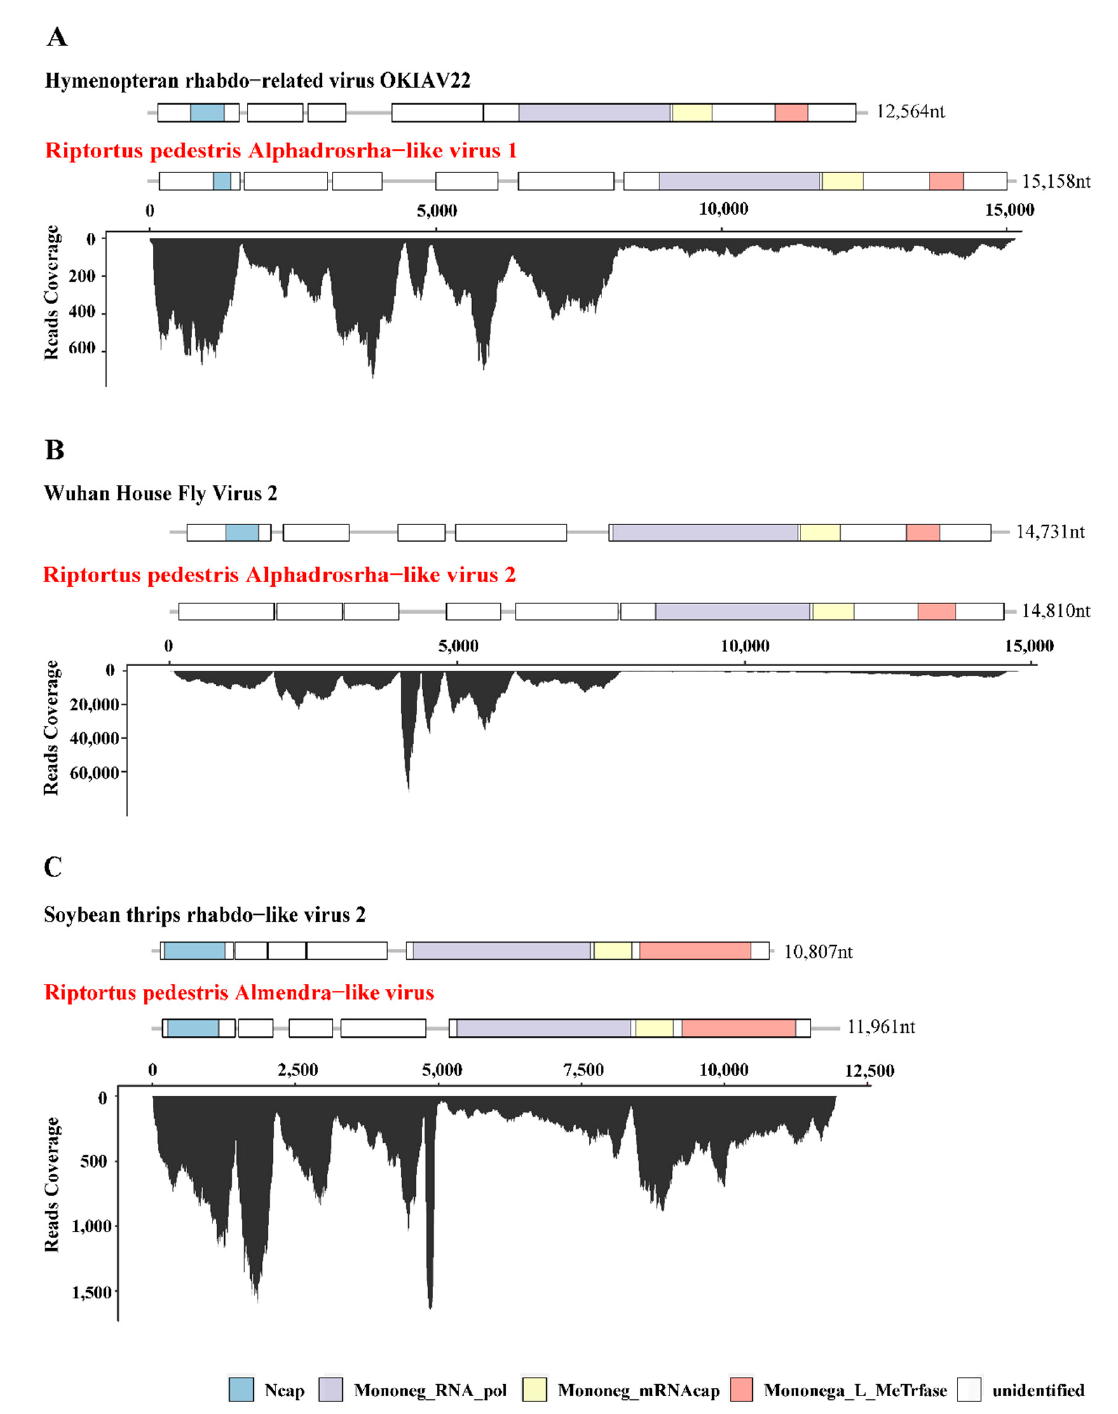
Figure 1. Genome structure and transcriptome raw read coverage of three novel insect-specific viruses identified in R. pedestris. The viruses were divided into 3 groups as shown in panels ( A – C ). Each panel contains two viruses, the reference genome with high homology on the upper panel (with black font) and the novel virus identified in R. pedestris on the lower panel (with red font). Each box represents an open reading frame (ORF) of the viruses. Conserved functional domains are color-coded and the corresponding names were shown at the bottom of the figure. Abbreviations of the conserved domain names: Ncap, Rhabdovirus nucleocapsid proteins; Mononeg_RNA_pol, Mononegavirales RNA dependent RNA polymerase; Mononeg_mRNAcap, Mononegavirales mRNA-capping region V; Mononega_L_MeTrfase, Virus-capping